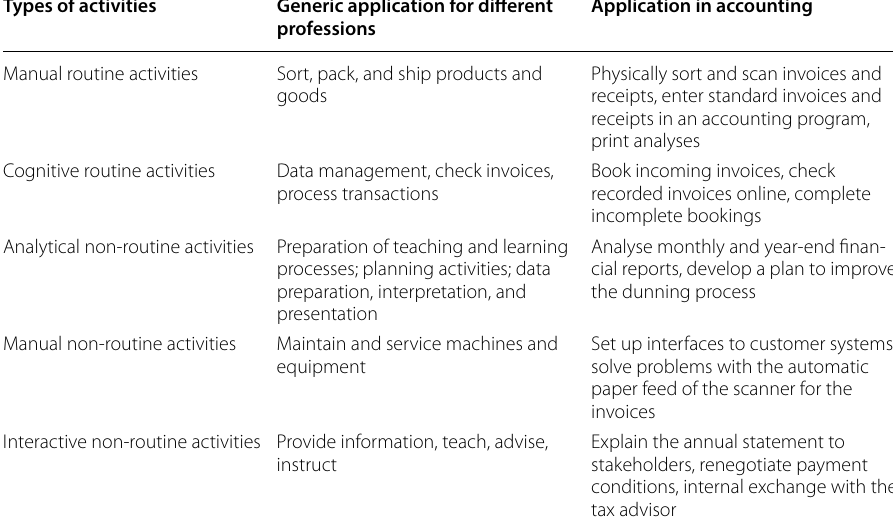
Table 1 Types of activities (Aepli et al. 2017, 41, examples freely translated and supplemented) Types of activities Generic application for different